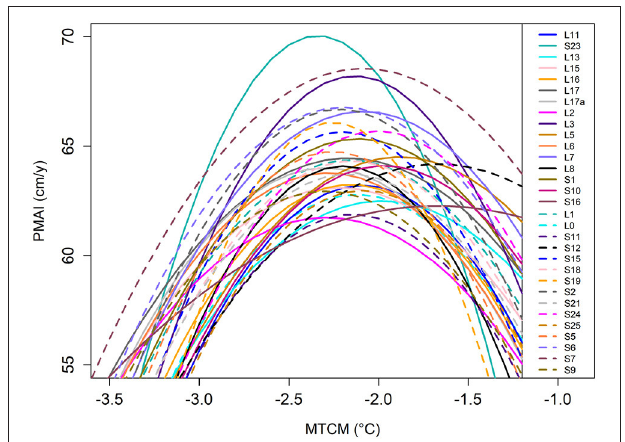
FIGURE 4 | RF at the family level (solid and dashed lines). PMAIs are plotted against the MTCM of the testing sites.